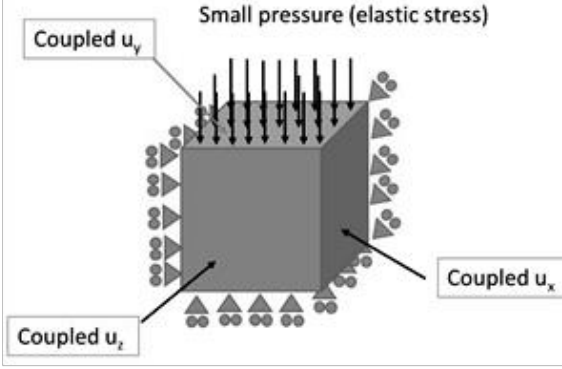
Fig. 2. Loading and boundary conditions of cubical